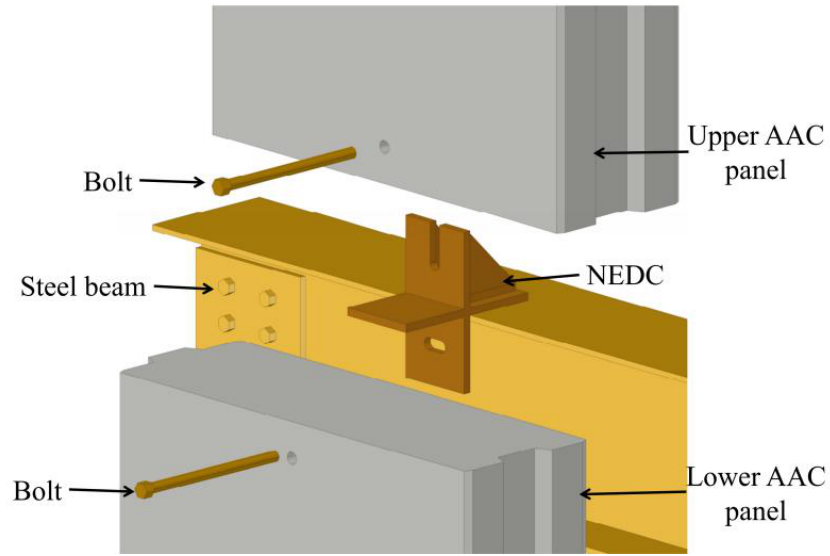
Figure 4. Schematic of NEDC connecting the upper and lower AAC wall panels.